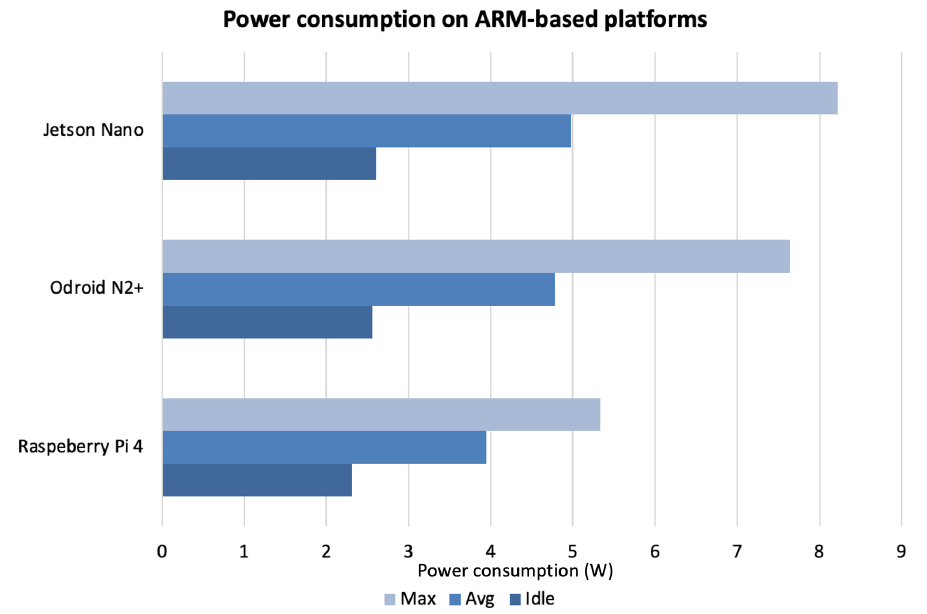
Figure 8. Idle, average, and maximum power consumption (W) in ARM-based embedded boards.